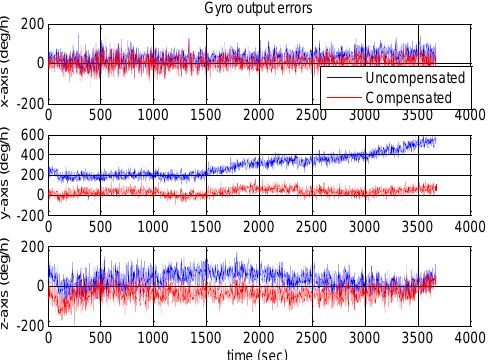
Figure 13. NV-IMU100 gyro output errors with and without compensation.